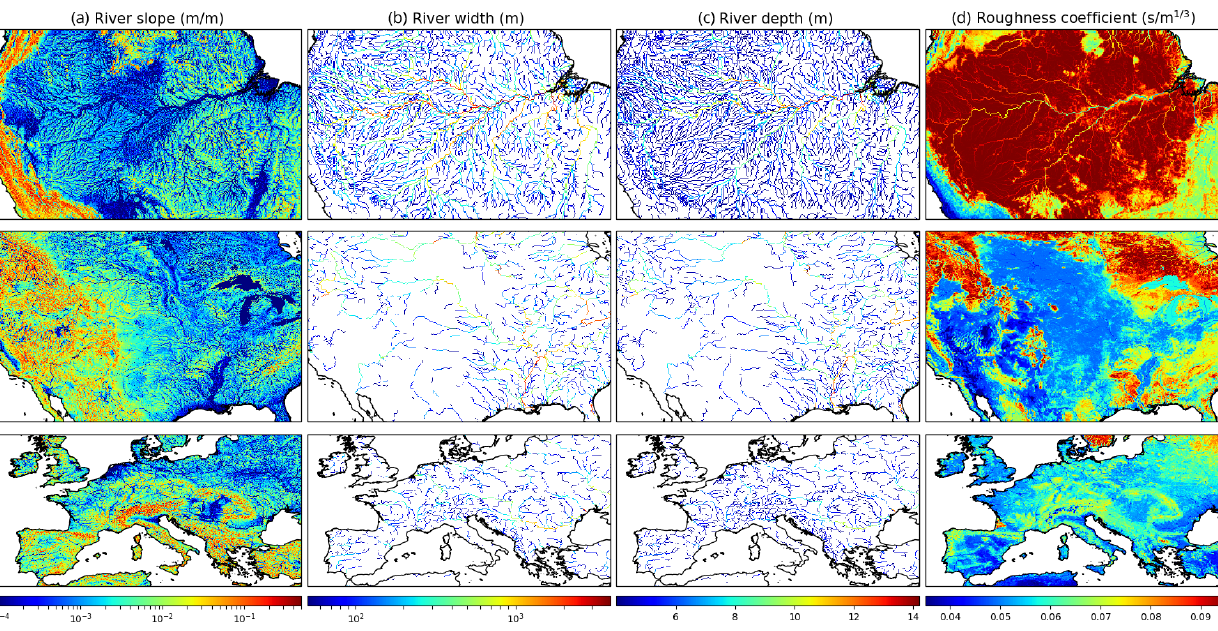
Figure 12. River parameters for the Amazon (first row), the USA (second row) and Europe (third row): river slope (a) , river width (b) , river depth (c) and roughness coefficient (d) . River widths smaller than 50m and river depths smaller than 4m have been filtered out for